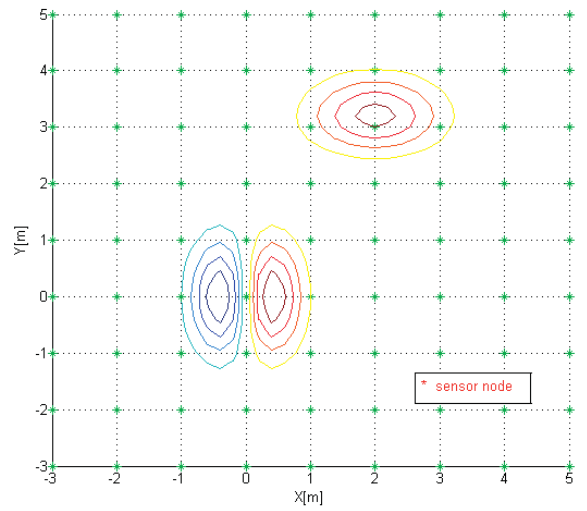
Figure 8. Initial Sensor Node